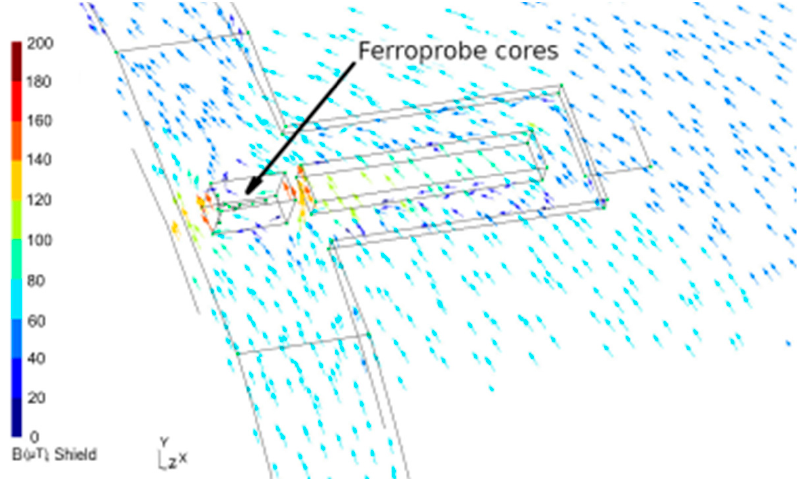
Figure 9. Magnetic fluxes in the shield housing near the D2 ferroprobe location.